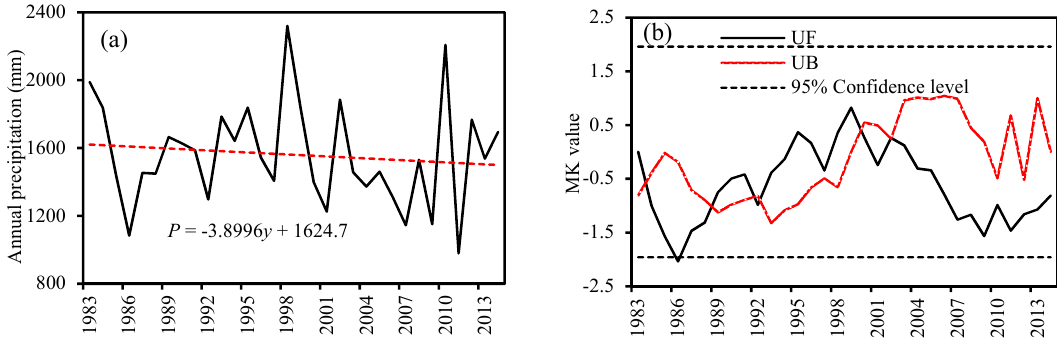
Figure 4. Inter ‐ annual variation of observed precipitation ( a ) and its Mann–Kendall (MK) test results ( b ) in Pengchongjian small watershed. in 1983–2014.